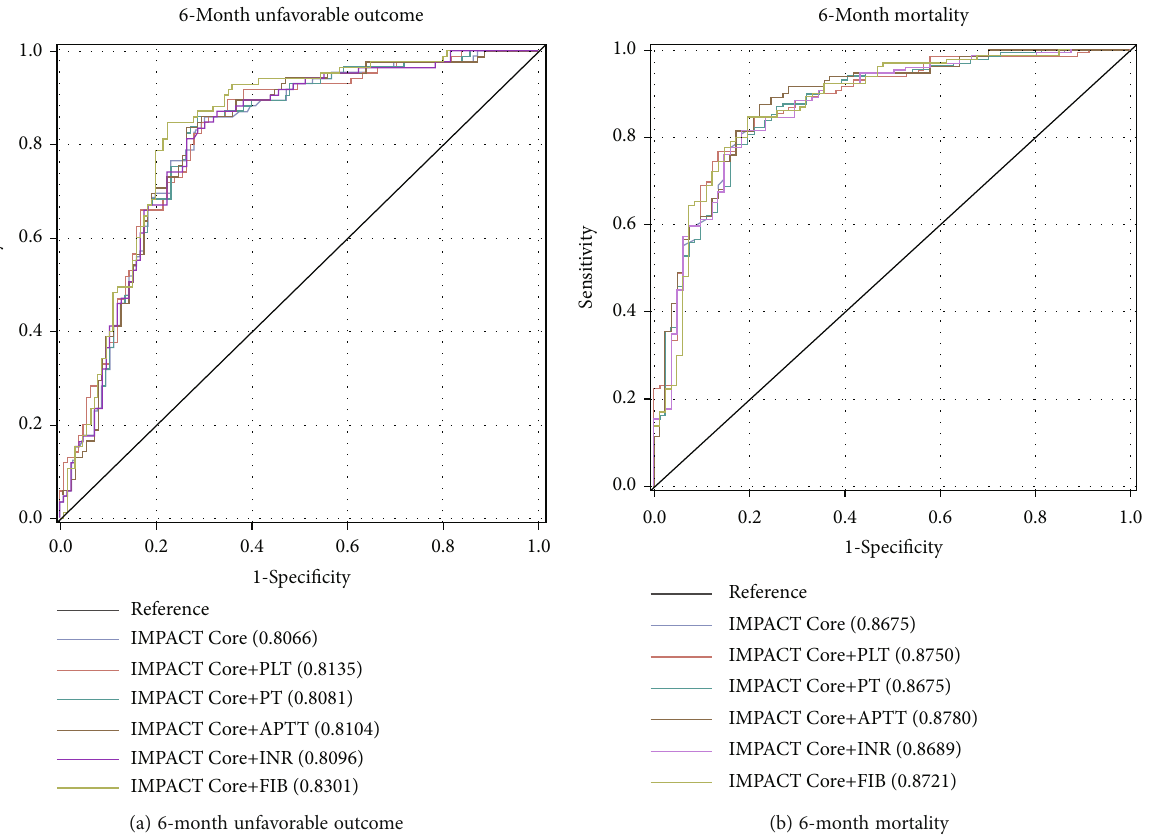
Figure 1: ROC curves of IMPACT Core and coagulation for 6-month adverse outcomes and mortality. (a) ROC curves for 6-month unfavorable outcome of IMPACT Core and coagulation. (b) ROC curves for 6-month mortality of IMPACT Core and coagulation.